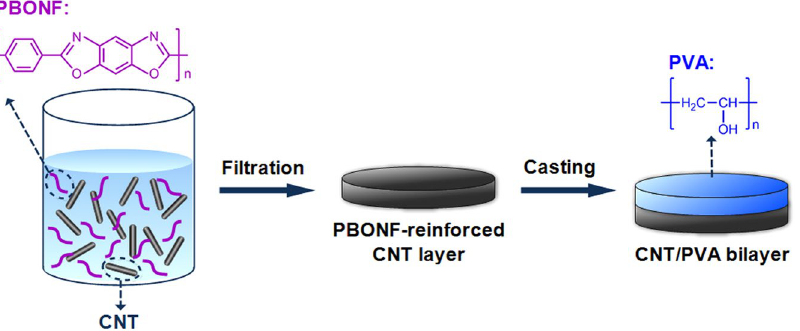
Figure 1. Schematic illustration of the fabrication procedure for the PBONF-reinforced CNT/PVA bilayer